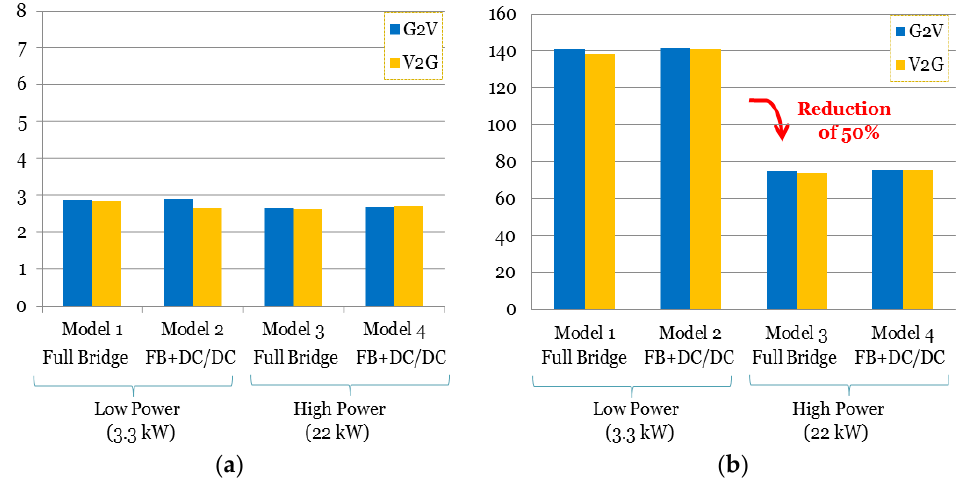
Figure 24. Total Harmonic Distortion of the AC waves in the four studied topologies. ( a ) Grid Current THD; ( b ) AC Voltage THD.